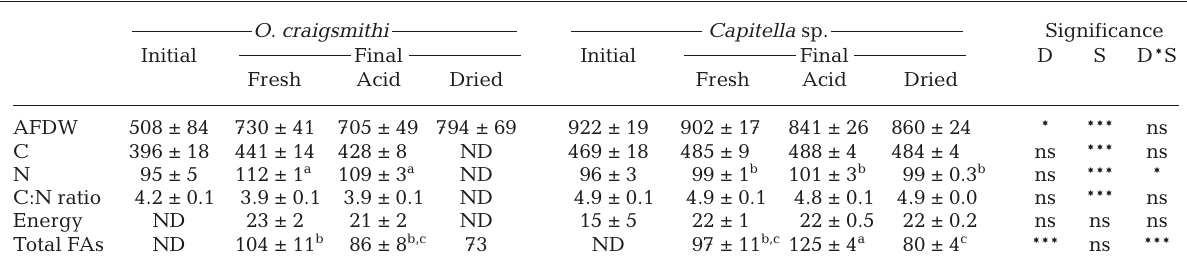
Table 2. Body composition of the 2 polychaete species ( Ophryotrocha craigsmithi and Capitella sp.) fed 3 different diets (defined in Table 1). Values are mean ± SD. For initial and final body composition, n = 3 and 4 tanks treatment −1 , respectively, except for C and N content of O. craigsmithi (acid), where n = 3 tanks, and total FAs of O. craigsmithi (dried), where n = 2. For some samples, not enough material was available to analyze all body composition parameters. This is indicated by ND (not determined). D: diet; S: species; other abbreviations, units and significance as in Table